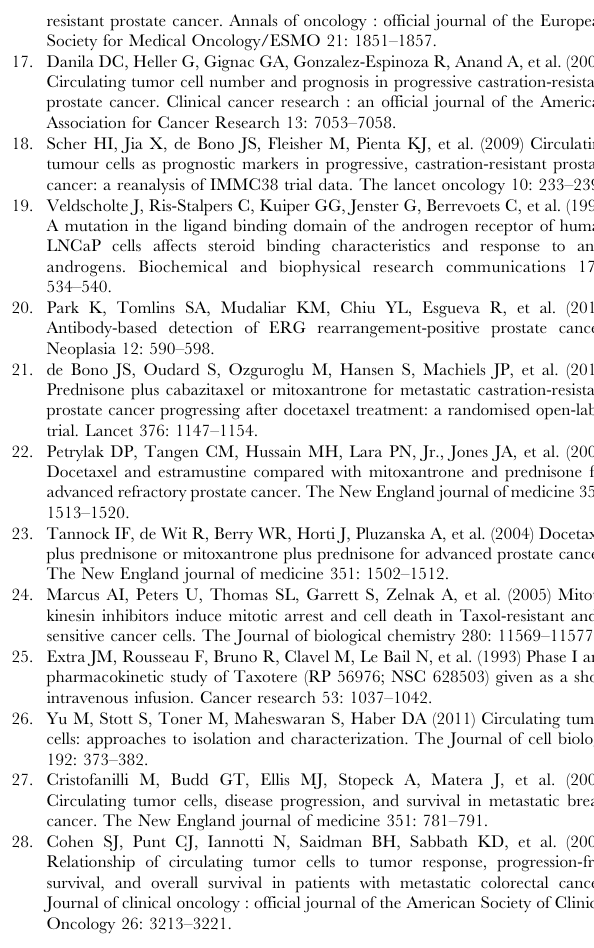
displayed. Note the nuclear ERG staining in fusion-positive vCaP cells. (B) Two hundred vCaP cells were spiked in 1 ml of healthy- donor blood, flown through the GEDI device and processed for ERG immunofluorescence labeling. Nuclear ERG staining was detected in the GEDI-captured vCaP cells, identified as PSMA + / DAPI + /CD45 2 cells. (C) Representative example of ERG- negative/CD45 + leucocytes identified in the blood from a CRPC patient processed by the GEDI device as in Figure 4B. Figure S4 Additional examples of on-chip assessment of effective drug-target engagement from different CRPC patients: taxane-induced microtubule bundling and mitotic defects as evidence of drug-target engagement in GEDI-captured CTCs. (A) GEDI-captured CTCs from the same patient as in Figure 5B. PTX-induced prometaphase arrest of GEDI-captured CTCs provides additional evidence of effective drug-target engagement. (B) GEDI-captured CTCs from patient 3 following ex vivo on-chip treatment with 100 nM DTX do not show any evidence of microtubule response (bundling) to drug treatment. (C) GEDI-captured CTCs from patient 2 display microtubule bundling (arrow) following ex vivo on-chip treatment with 100 nM or 1 m M PTX. (D) GEDI-captured CTCs from patient 4 following ex vivo on-chip treatment with 50 nM PTX show heterogeneous response to drug treatment. Note, distinct microtubule bundling in a PSMA + CTC (middle panel, barbed arrow) and no detectable microtubule network in another PSMA +